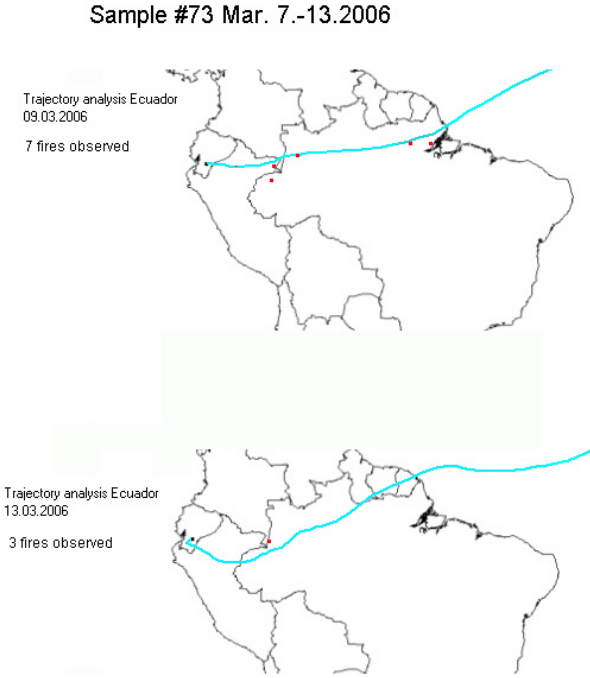
Fig. 12. Same as Fig. 8, but for sample